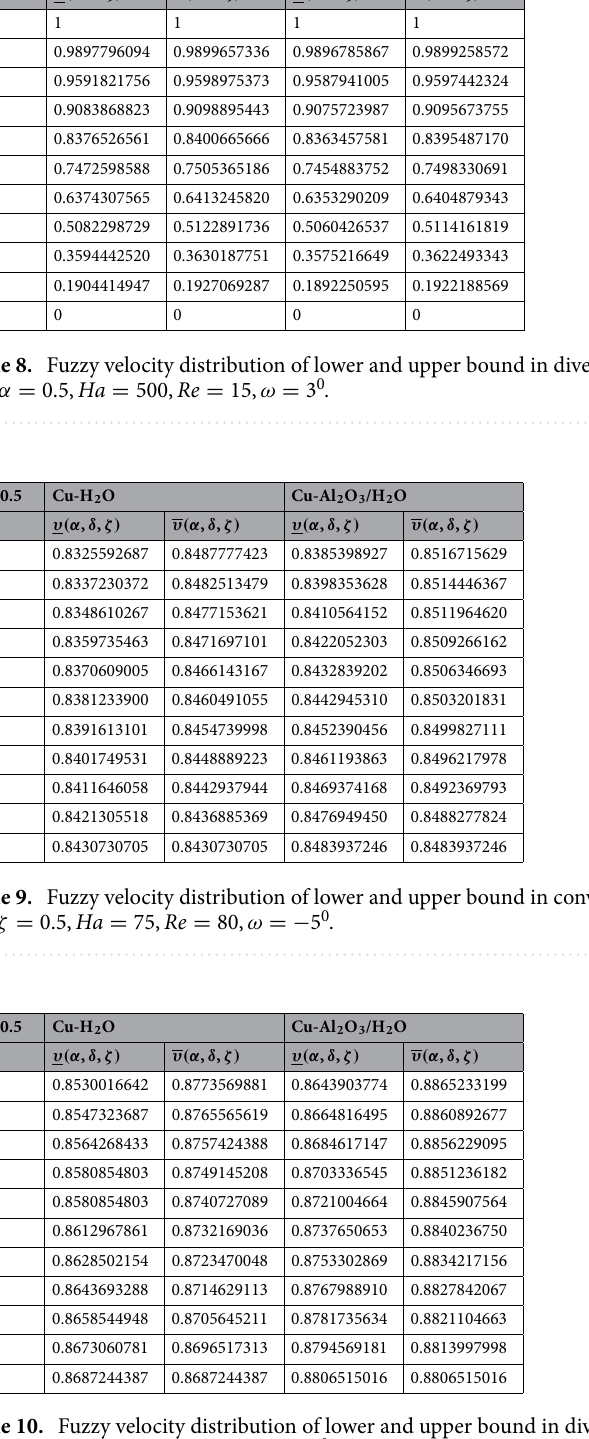
Table 10. Fuzzy velocity distribution of lower and upper bound in diverging channel when for various values α and ζ = 0.5, Ha = 75, Re = 80, ω = 5 0 .